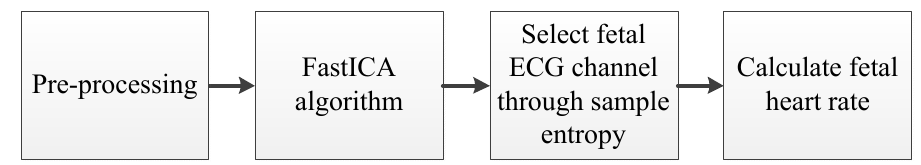
Figure 5. Flow chart of fetal ECG extraction.